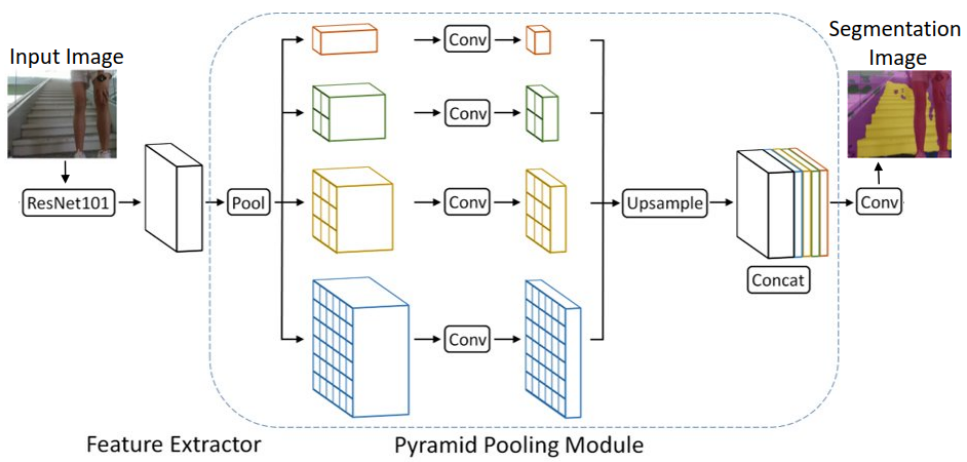
Figure 3. Pyramid pooling